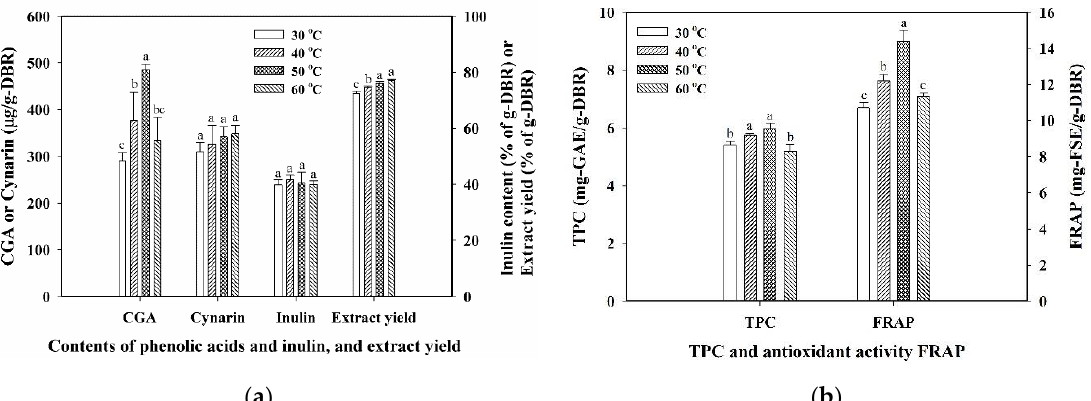
Figure 2. Effect of temperature on ( a ) contents of chlorogenic acid (CGA), cynarin, inulin, and extract yield, and ( b ) total phenolic content (TPC) and ferric-reducing antioxidant power (FRAP). Conditions: 40 kHz/300 W of ultrasound, 10 min of extraction, and 1/30 (g/mL-water) of solid-to-liquid ratio. Data were expressed as mean ± standard deviations from triplicate experiments. Different superscript letters at the same group were significantly different ( p < 0.05) by the Duncan ’ s test.